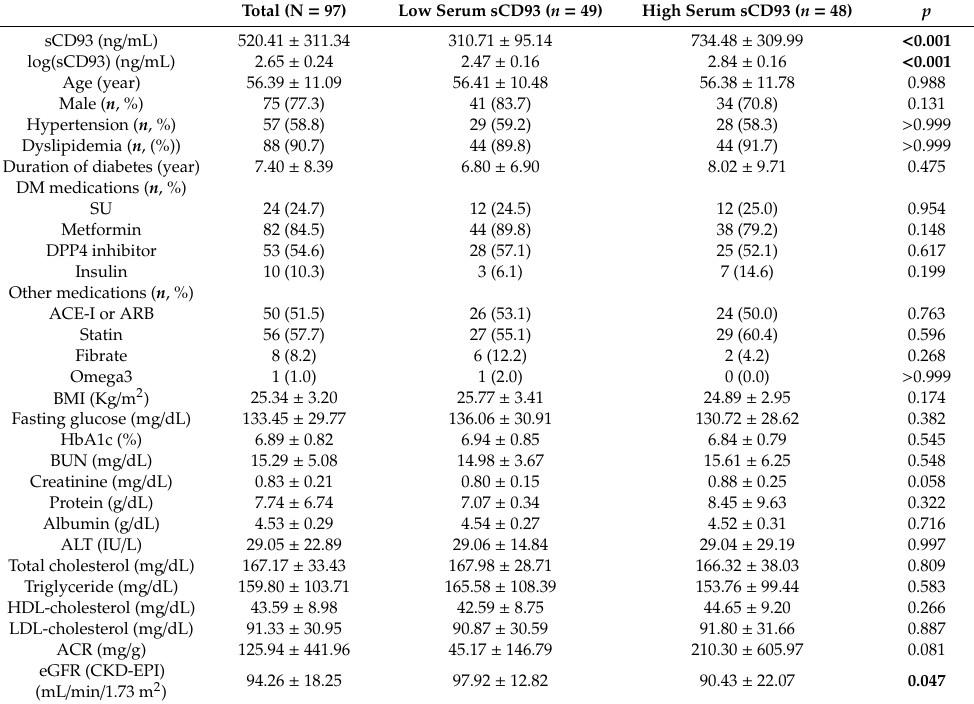
Table 1. Clinical characteristics of the study population according to serum sCD93